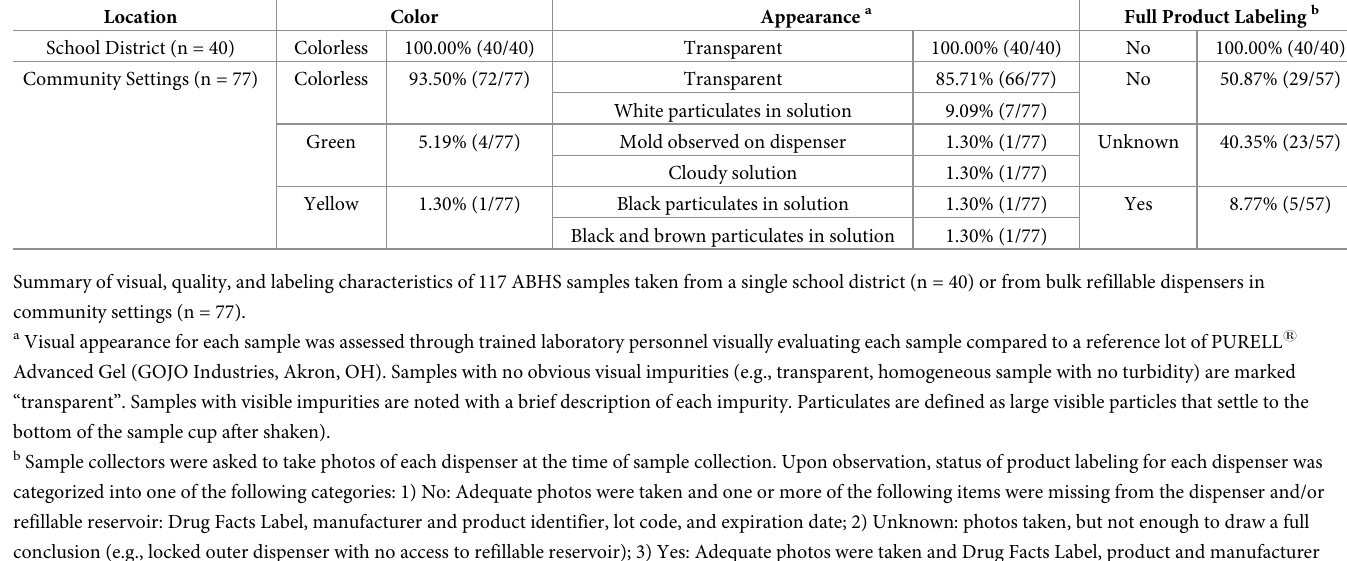
Table 1. Visual and quality characteristics of ABHS samples obtained from bulk refillable dispensers in community settings.